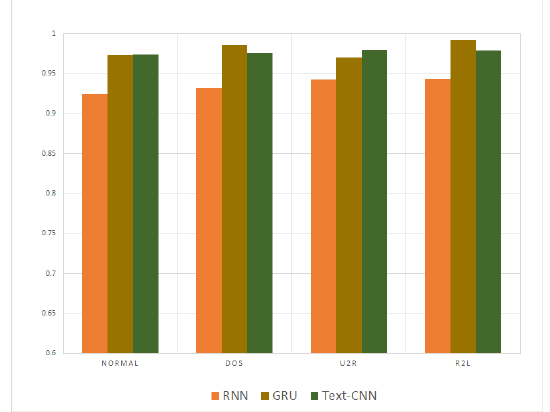
Figure 13. F1-score of the entire KDD99 dataset.